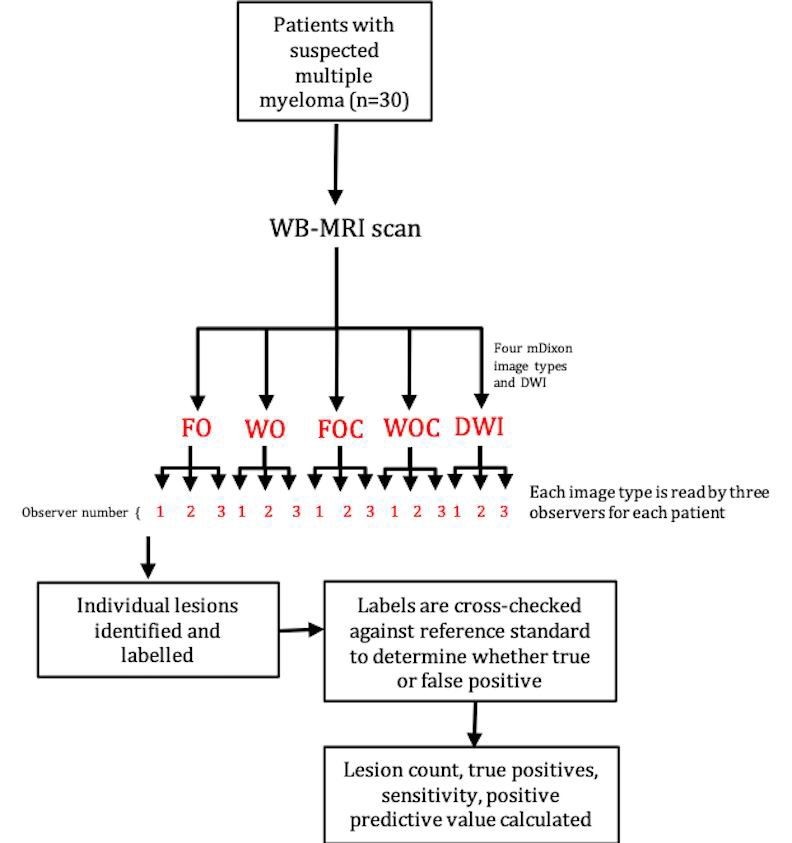
Study design (15).